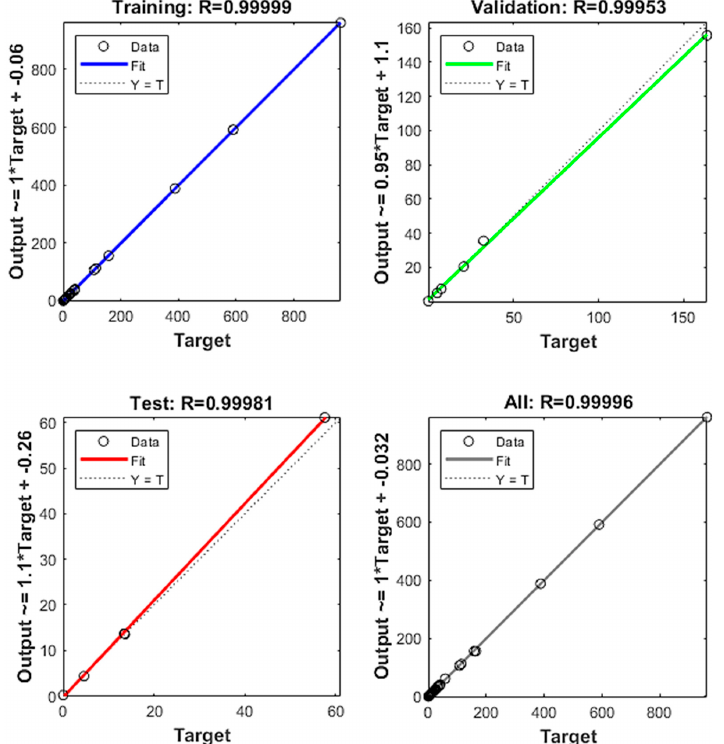
Figure 16. Comparison of predicted and observed TEC values for the training, validation, and testing phases in the dry season.